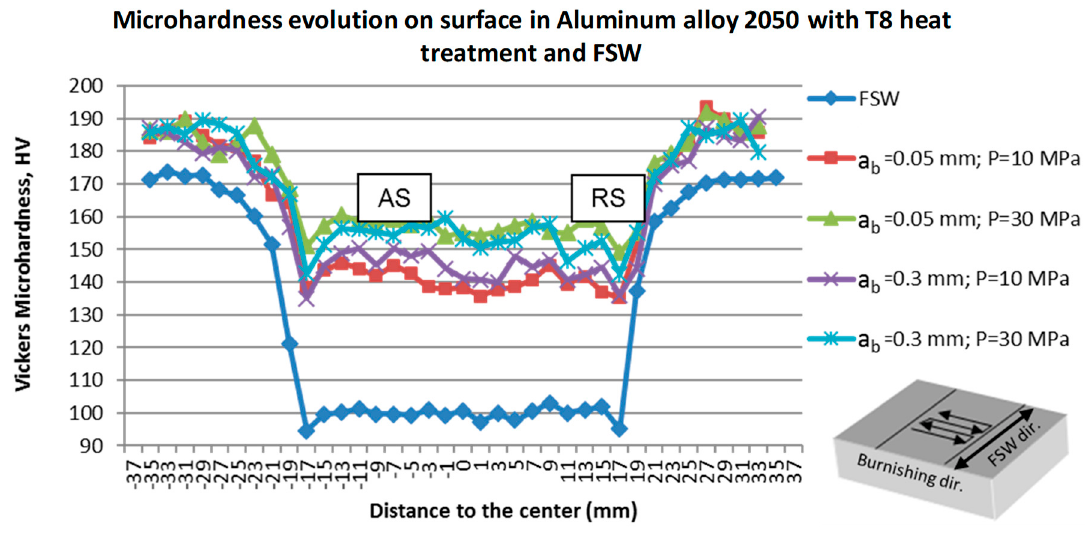
Figure 9. Microhardness evolution with burnishing applied perpendicular to the welding direction.